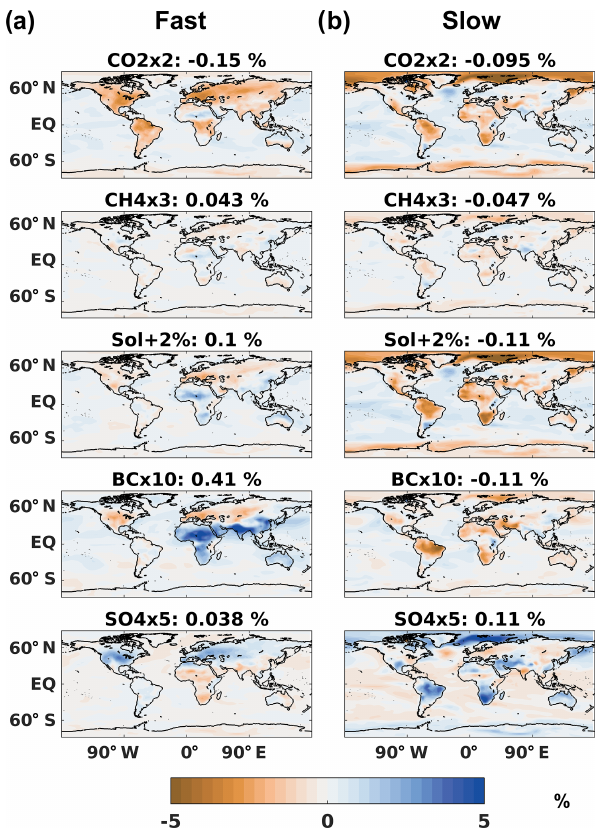
Figure 3. Maps of model-mean absolute change in near-surface relative humidity (%) for each PDRMIP driver, separated into (a) fast and (b) slow responses. The plots are means of the six models with available data for near-surface relative humidity: CanESM2, HadGEM2, MIROC-SPRINTARS, NCAR-CESM1- CAM4, NCAR-CESM1-CAM5, and